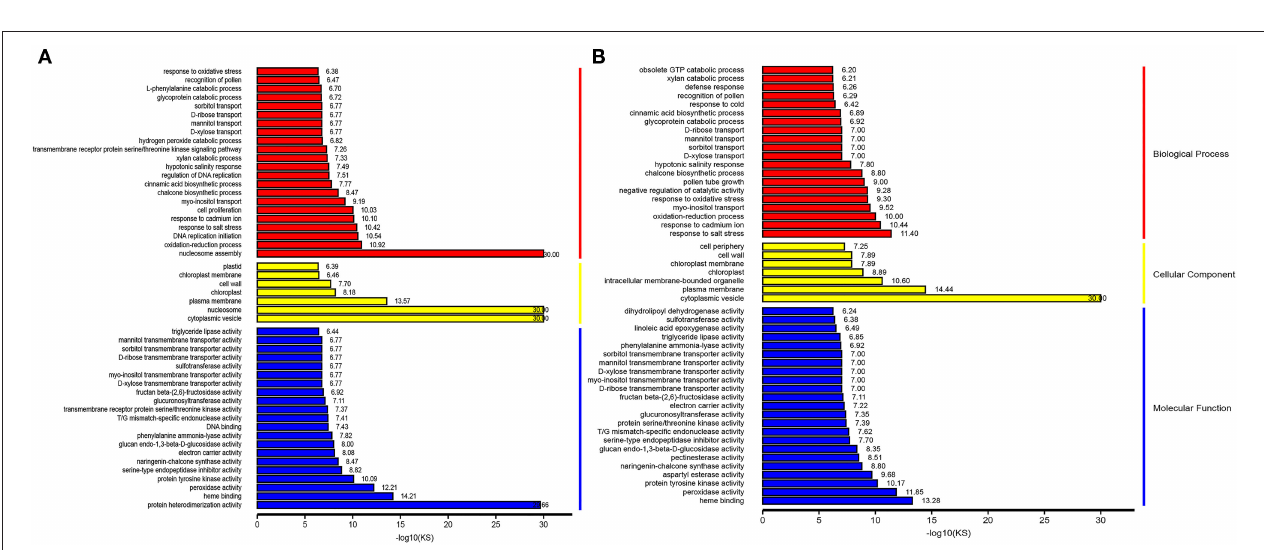
FIGURE 4 | The volcano plot and MA plot show the changes in the abundance of unigenes between fertile anthers and HT-ms anthers. Each dot in the volcano map represents a gene. Green dots indicate significantly downregulated DEGs, red dots indicate significantly upregulated DEGs, and black dots represent non-DEGs. (A) Volcano plot; the abscissa represents the log 2 (FC) in the expression of a certain gene in two samples; the ordinate represents the negative log10 (false discovery rate [FDR]) in gene expression. (B) The abscissa is the A value: log2 (FPKM), which is the logarithmic value of the mean value of the expression in the two samples; the ordinate is the M value: log2 (FC), which is the logarithm of the fold difference in gene expression between the two samples.